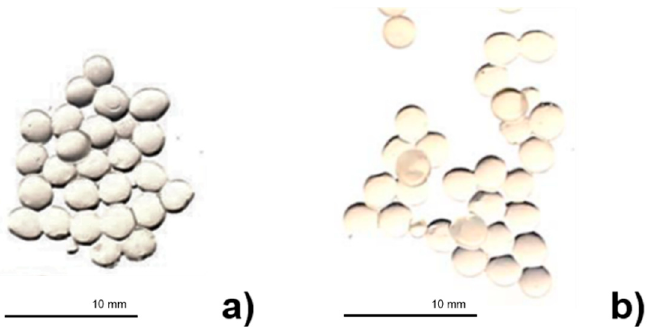
Figure 3. Digital images of ( a ) the empty alginate microspheres and ( b ) the DHA-alginate micro-